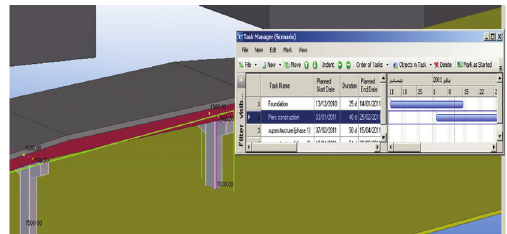
Fig. 8. Generating 4D